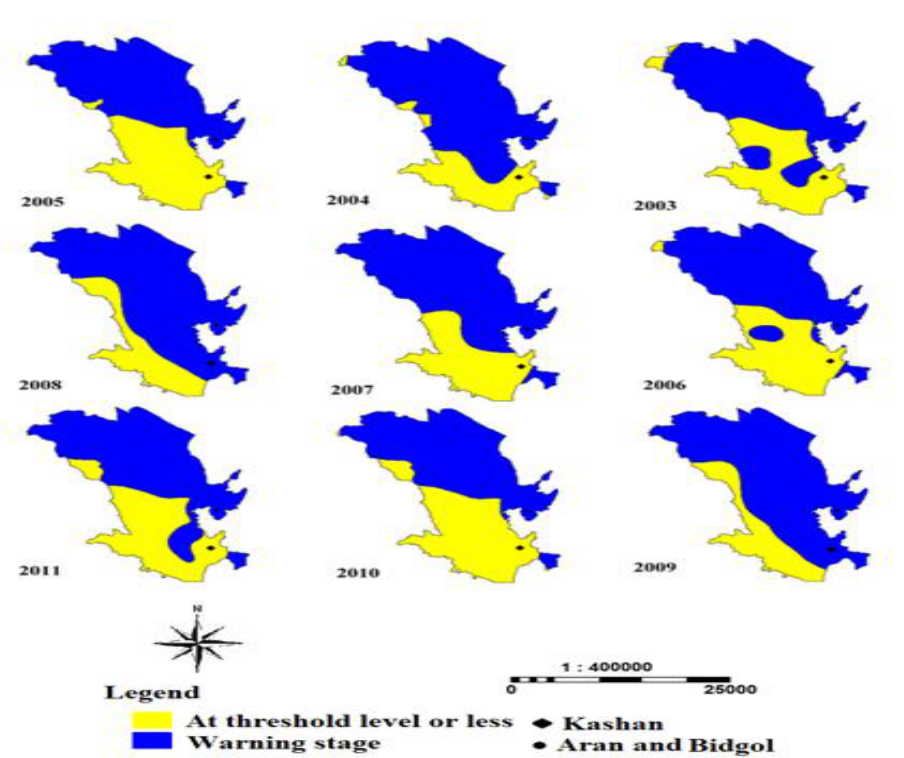
Figure 7. The areas under warning stage based on EC